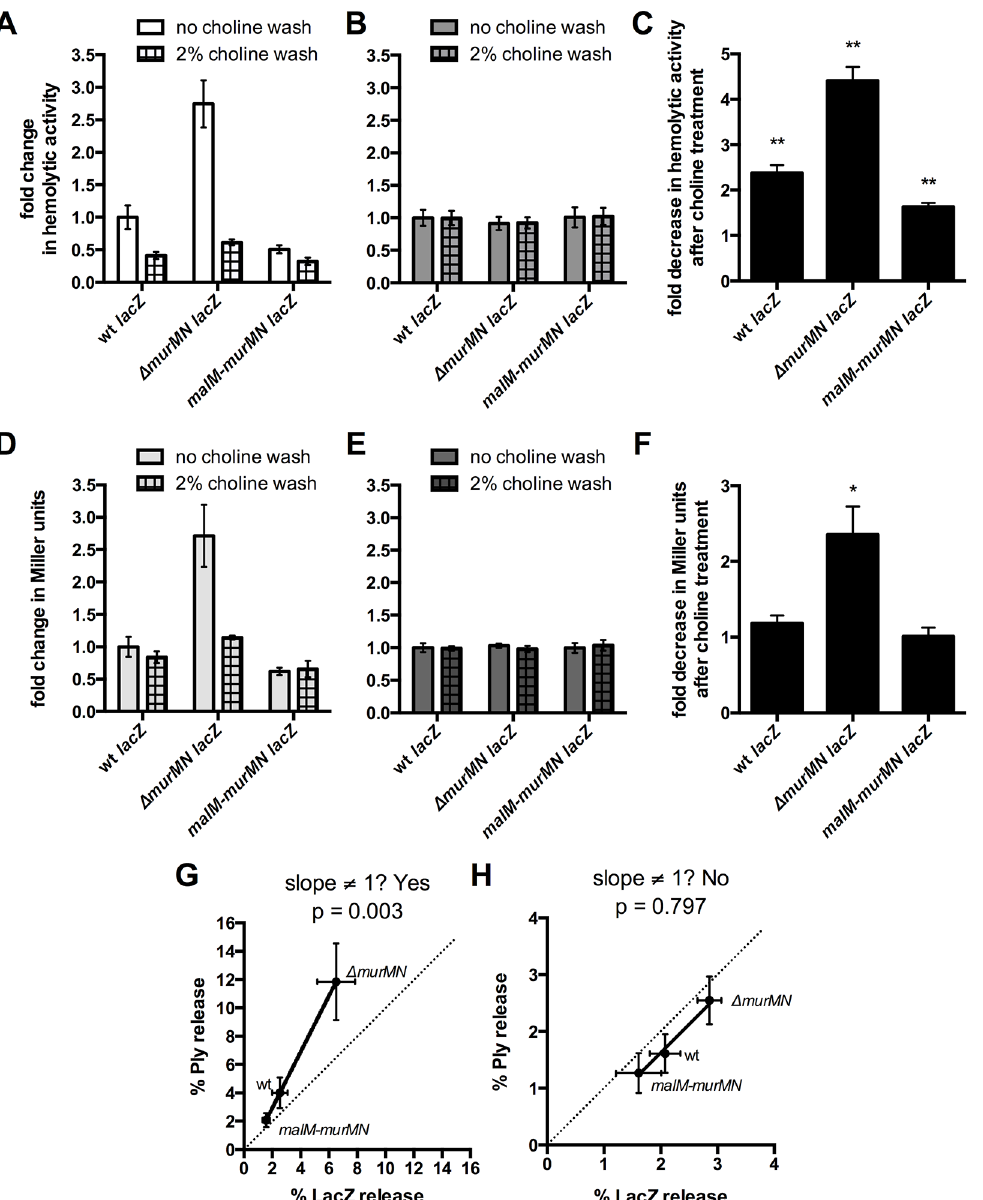
Fig 3. Choline-binding proteins contribute to Ply and LacZ release in a murMN -dependent manner. The endogenous β -galactosidase gene, bgaA , was replaced with E . coli lacZ expressed from a constitutive promoter in wt, Δ murMN , and malM-murMN and the resulting strains were tested for hemolytic (A-B) and β -galactosidase (D-E) activity after incubation without or with 2% choline chloride. Strains were tested for both activities as whole cells (A, D) and sonicated lysates (B, E) . The fold decrease in hemolytic (C) and β -galactosidase (F) activity between the choline-treated and control groups of each strain was quantified. Columns represent the mean and error bars denote SEM of four biological replicates. In (A-B, D-E) the data are presented as the fold change in measured activity compared to the wt no choline wash group. * p < 0.05, ** p < 0.01, One sample t test compared to a value of 1.0, which indicates no change. (G-H) Percent Ply and LacZ release was calculated for each strain in both conditions by dividing the whole cell activity in (A) or (D) by the sonicated lysate activity in (B) or (E) , respectively. The calculated values were plotted against each other for the control (G) and choline-treated (H) groups such that each symbol represents a different strain with error bars indicating SEM. Data were fit to a straight-line model and the resulting slope was compared to a hypothetical value of 1.0, which represents equal change between the two variables measured and is indicated by the dotted